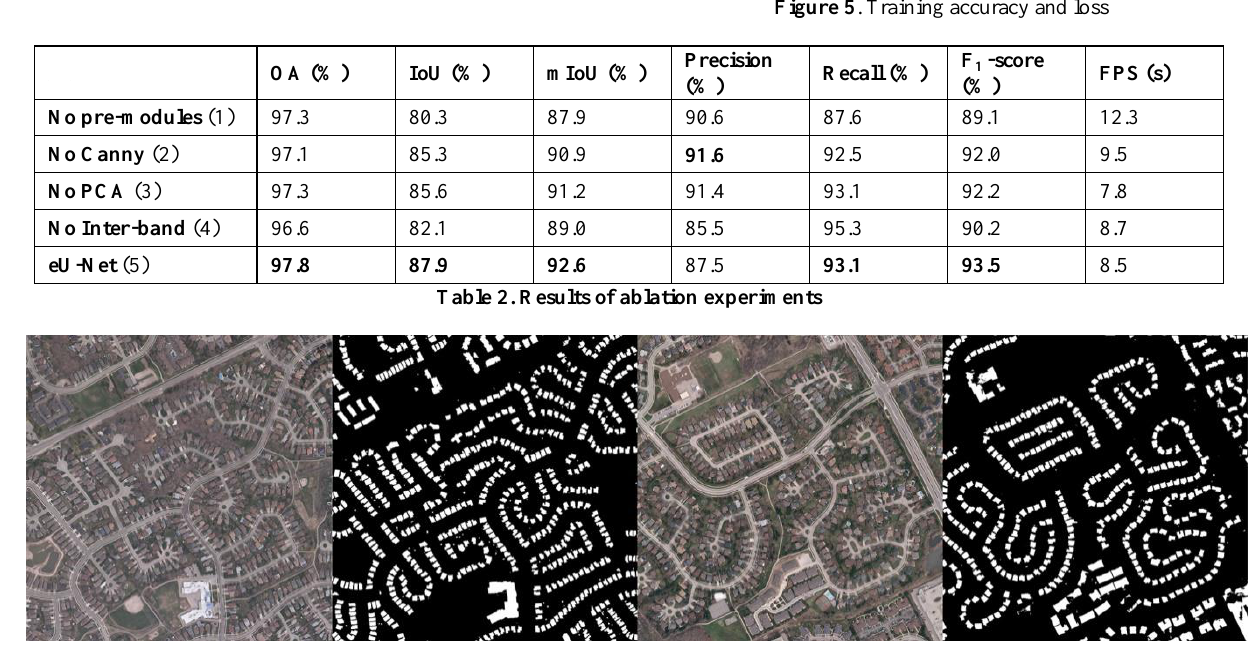
Figure 5 . Training accuracy and loss